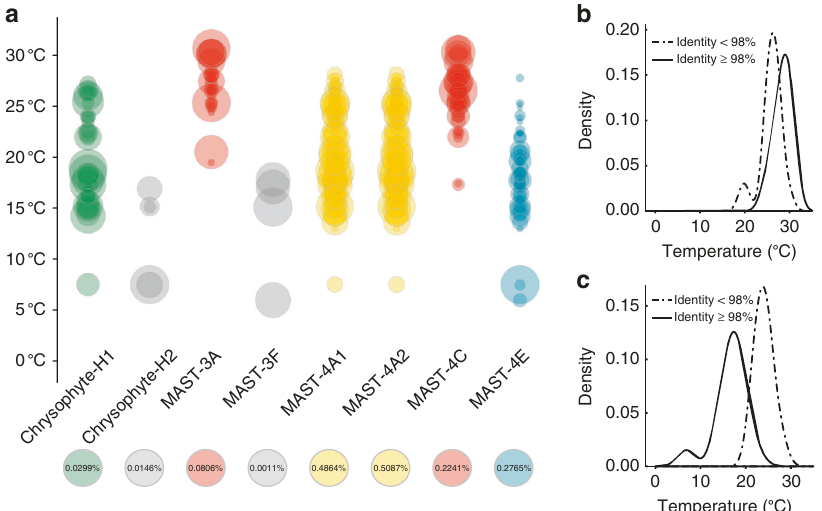
Fig. 4 Water temperature and distribution of the heterotrophic protists. a x -axis represents the lineage composite genomes, and y -axis represents surface temperatures in degrees Celsius at each sampling location. Relative abundances are represented by circle size (one per station/depth where the genome was detected). The scale for each column is indicated below the name of the lineage. b MAST-3A abundance distribution relative to temperature. A difference in the distributions is observed with a p -value < 2×10 − 2 (Wilcoxon test). c MAST-4E abundance distribution relative to temperature. Means are statistically different with a p -value < 3×10 − 4 (Wilcoxon test). In b and c , line type indicates median sequence similarity to the reference genome